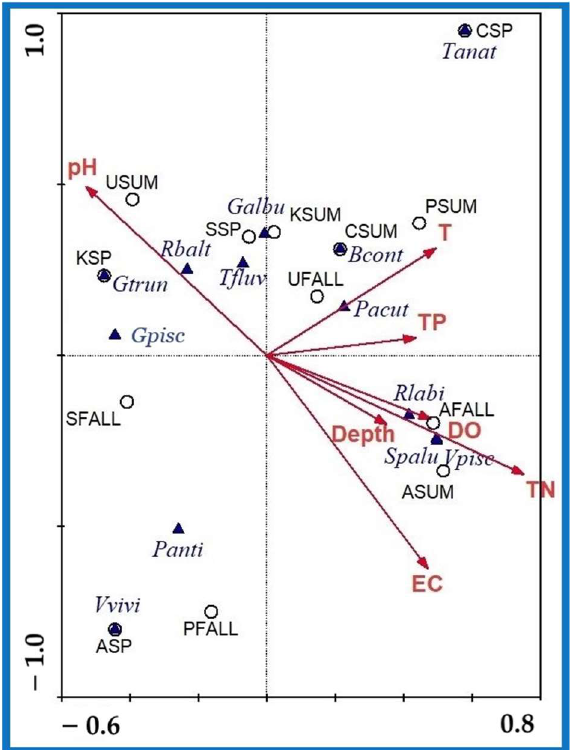
Figure 5. Canonical correspondence analysis triplot with lotic sites (red arrows: environmental